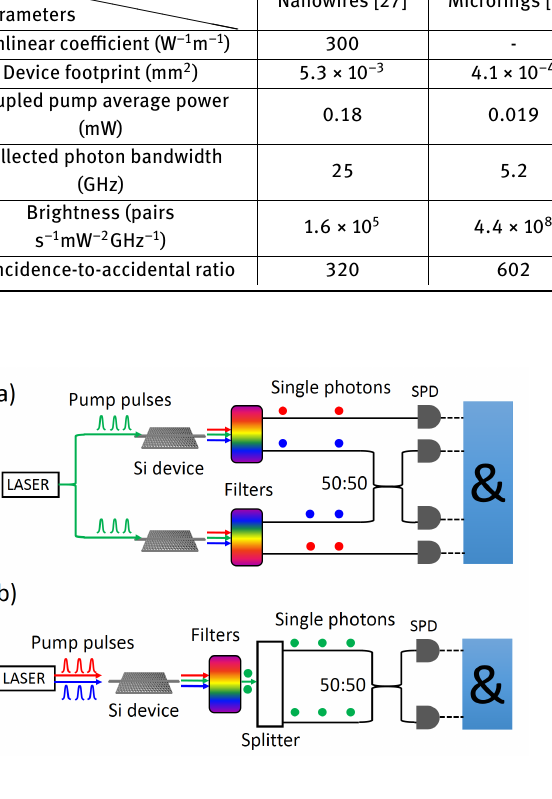
Fig. 8. Diagram for HOM interference when using (a) two indepen- dent heralded single-photon sources, and (b) one source that pro- duces indistinguishable photon pairs.